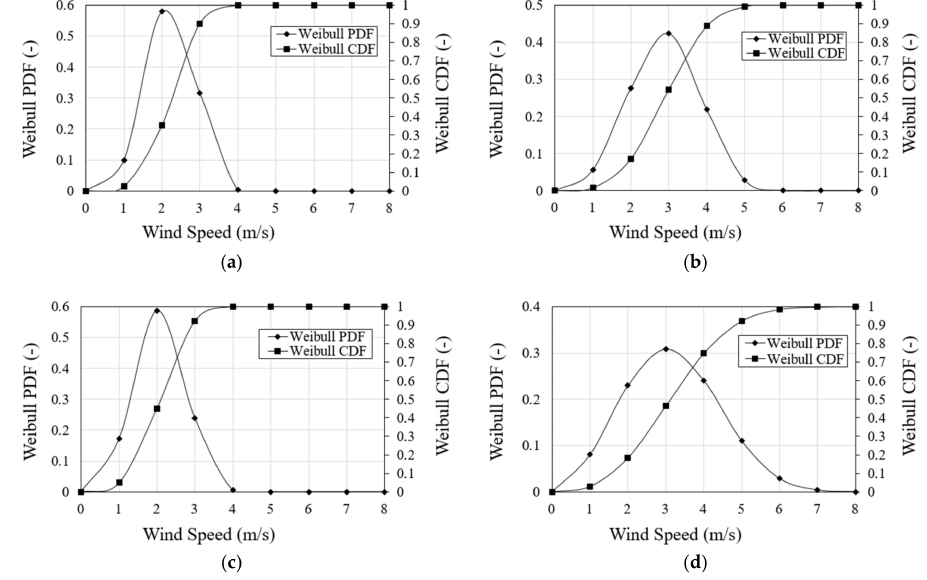
Figure 8. Season-wise plots of Weibull probability density function (PDF) and cumulative distribution function (CDF) at the test site using all predicted wind data: ( a ) Winter; ( b ) Spring; ( c ) Summer; ( d )